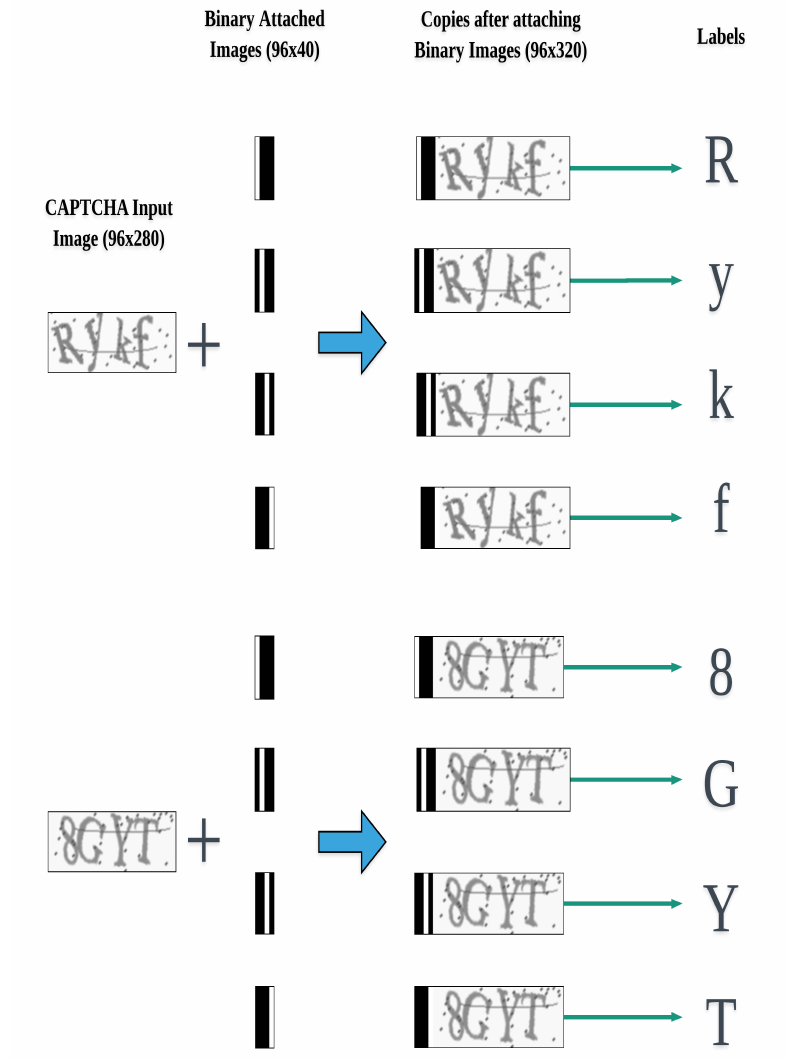
Figure 2. Description of main concept of the proposed method of CRABI